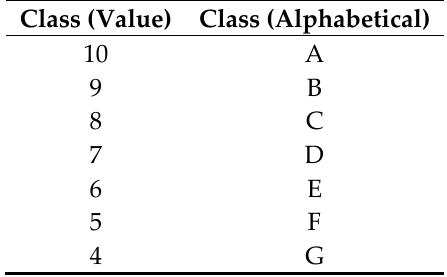
Table 1. Mapping the class of the EEMs with the corresponding numerical